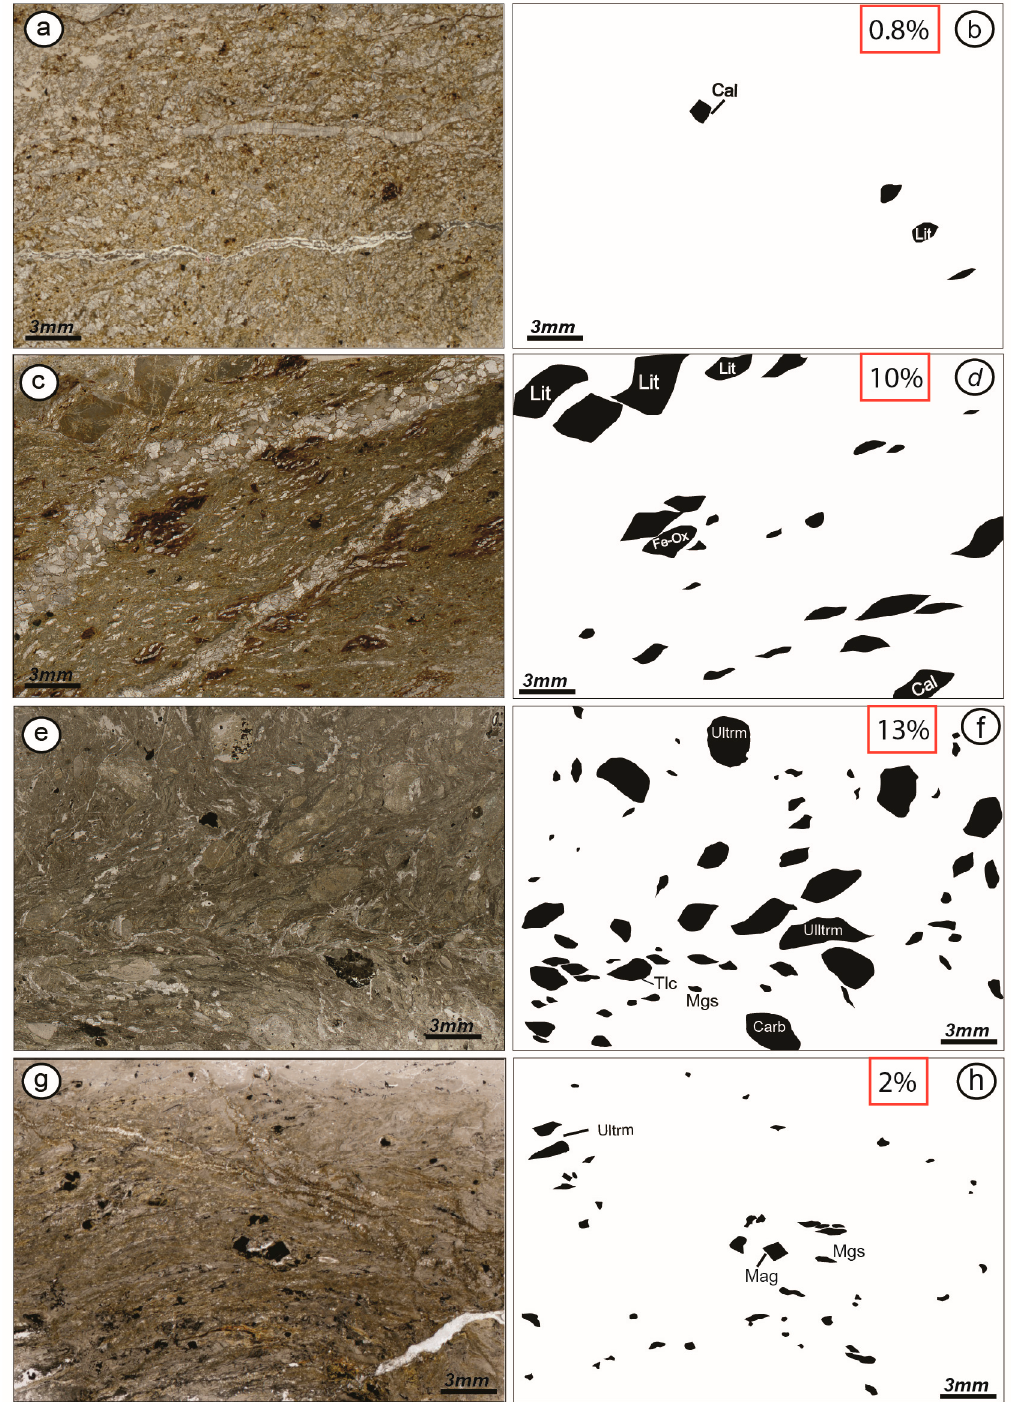
Figure 4. Area percentage occupied by porphyroclasts, as computed using image analysis. ( a , b ) quartzo-feldspathic protomylonite domain; ( c , d ) quartzo-feldspathic mylonitic domain; ( e , f ) myloniticserpentinite; ( g , h ) ultramylonite in serpentinite level. Srp: serpentine; Lit: lithic clast; Carb: carbonate clast; Mag: magnetite; Mgs: magnesite; Tlc: talc; Ultrm: ultramafic clast.